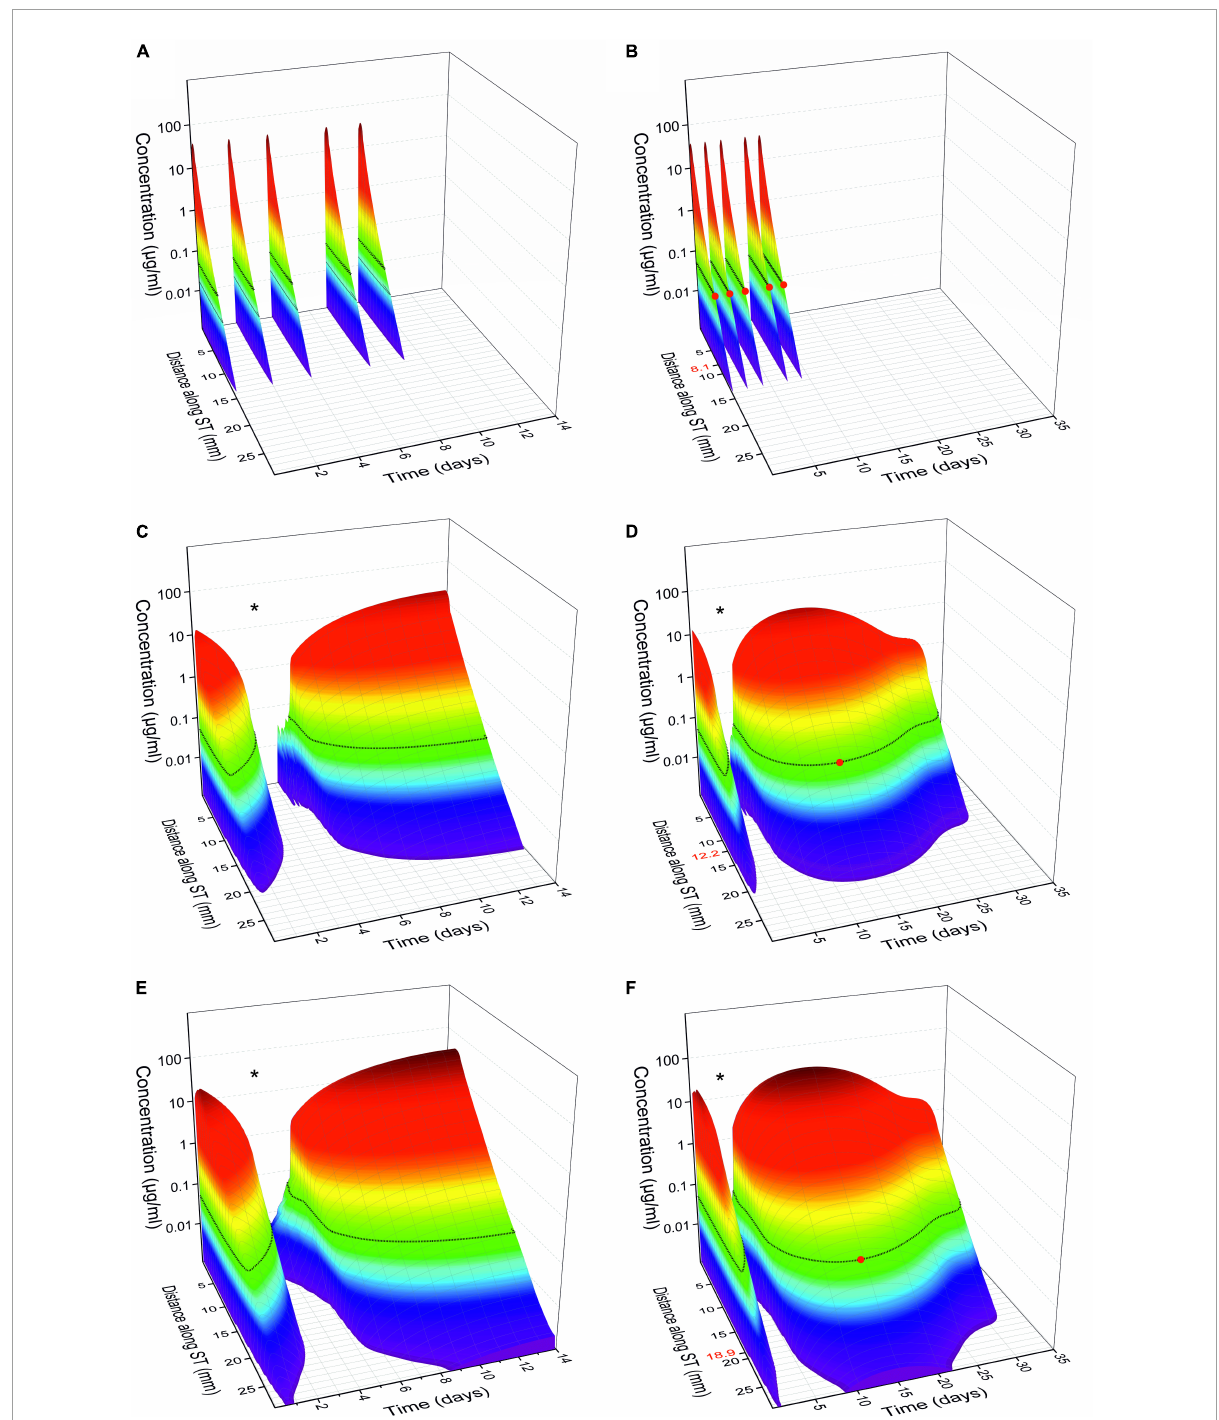
FIGURE11 Calculated glucocorticoid distribution in the perilymph of scala tympani (ST) over 14 and 35 days, respectively. (A,B) Intratympanic injection of 0.3 ml of a 4 mg/ml dexamethasone phosphate solution (once every 2 days, with an assumed pause of 3 days on the weekend, 5 injections in total). (C,D) Extracochlear application of the Ozurdex R (cid:13) implant (total dexamethasone: 700 µ g) on the RWM. (E,F) Intracochlear application of 1/2 Ozurdex R (cid:13) implant (350 µ g dexamethasone) in the basal region of scala tympani. The red dot on the black line in panels (B,D,F) and the corresponding red number on y -axis indicate the farthest apical spread when assuming a minimal therapeutic concentration of 50 ng/ml dexamethasone for inflammatory suppression (horizontal black lines on surface plots) (Liu et al., 2015, 2016; Bas et al., 2016; Liebau et al., 2020). The “dip” in the intracochlear concentration-time-distance curves [* in panels (C–F) ] can be explained by the plateau in the in vitro dexamethasone release kinetics of the drug delivery system (see Figure 12 ). When comparing the concentration time curves, it needs to be considered that dexamethasone phosphate (A,B) and dexamethasone (C–F) differ in their different molecular properties (Salt and Plontke,